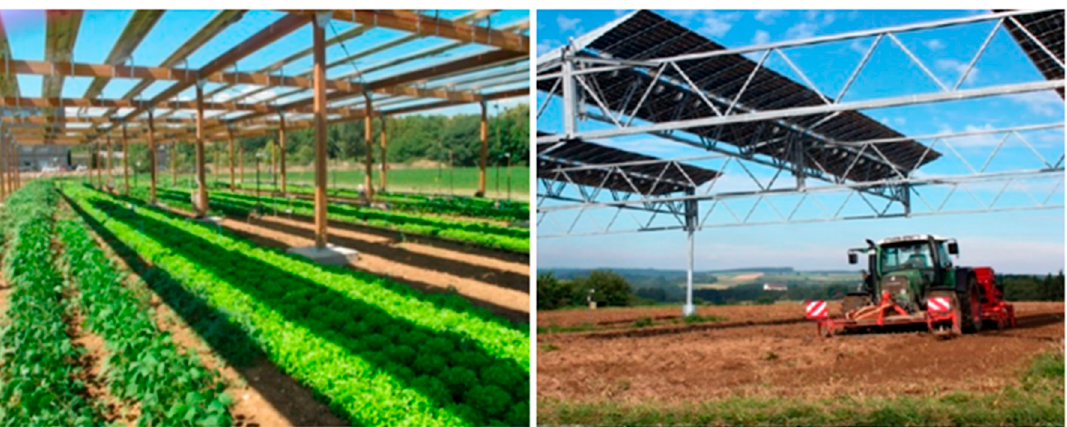
Figure 4. ( a ) Panels installed at the height of 4 m in Montpellier © Dupraz, ( b ) Panels installed at the height of 5 m in Germany © Fraunhofer ISE [33].